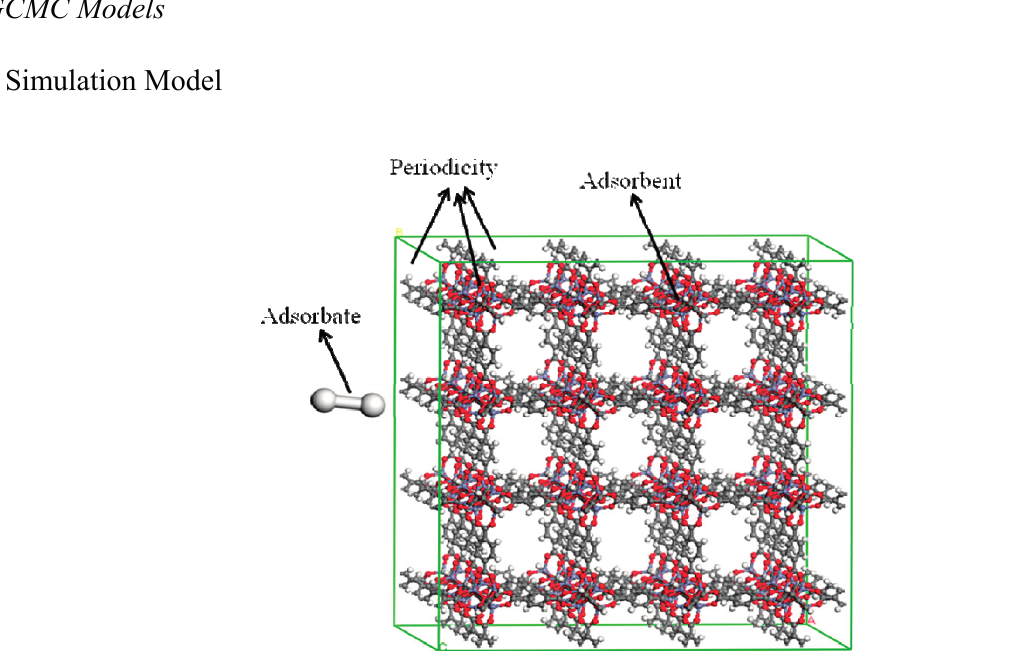
Figure 2. Computed physical